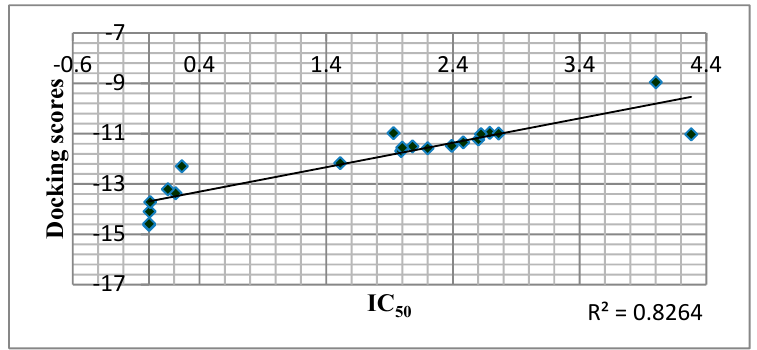
Figure 5. Correlation of Predicted Free Binding Energy of the Compounds in the Allosteric Center of the Enzyme with IC 50 of the Compounds.